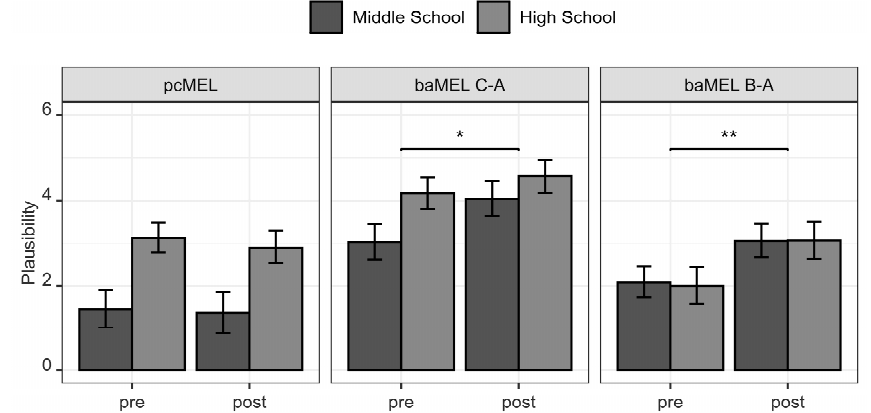
Figure 5. Plausibility scores (range: 1 (highly implausible)–9 (highly plausible)) for each instructional treatment. Errors bars indicated ±1 standard error. Asterisks indicate a statistically significant difference between pre- and post-instruction, * p < 0.05, ** p < 0.01.